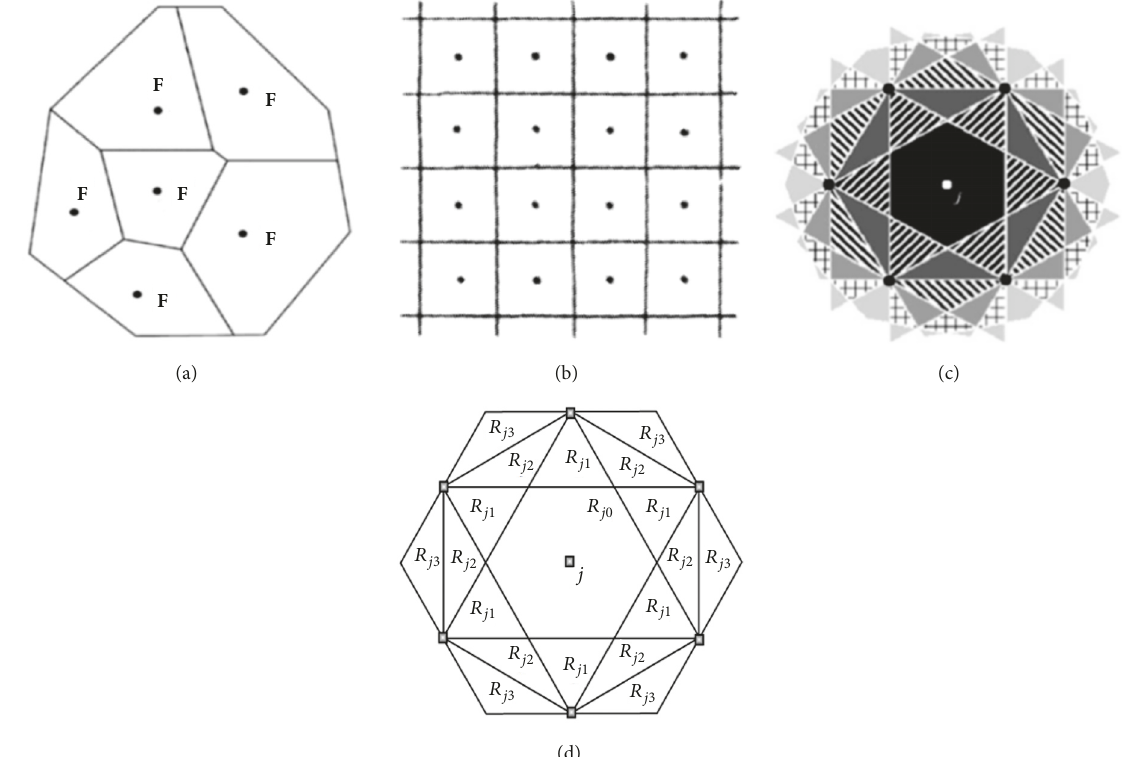
Figure 2: (a) Irregular partition of target plane; (b) chessboard grid partition of target plane; (c) quasi-regular geometric partition of target plane; (d) regular geometric partition of target